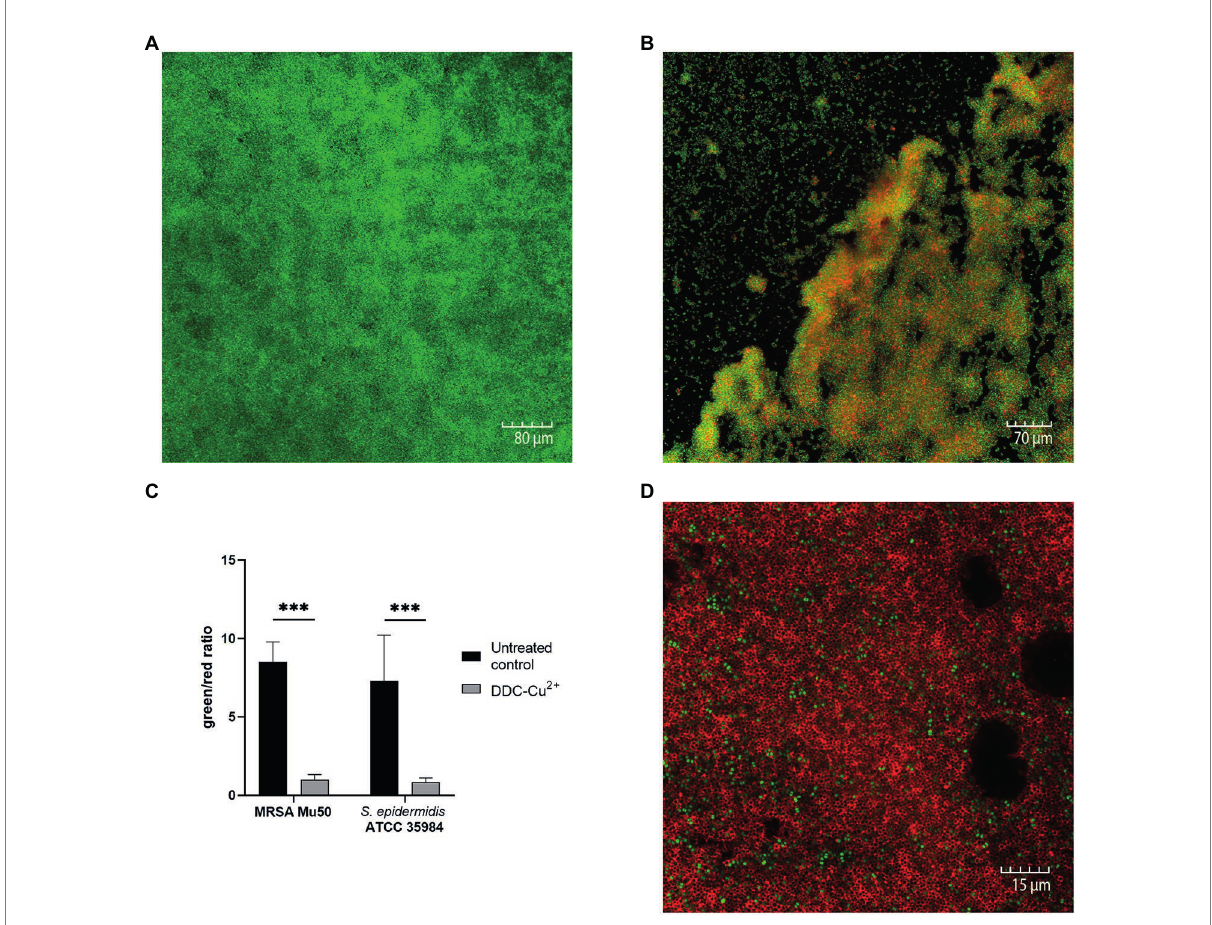
FIGURE 2 Comparison of stained MRSA Mu50 and S. epidermidis ATCC 35984 biofilms with LIVE/DEAD BacLight staining after treatment with 8 μ g/ml diethyldithiocarbamate and 32 μ g/ml Cu 2+ (DDC-Cu 2+ ). Confocal microscopy images results: green = viable bacteria; red = dead bacteria. (A) Untreated S. epidermidis ATCC 35984 biofilm at 20×. S. epidermidis ATCC 35984 biofilm after treatment with DDC-Cu 2+ at (B) 20× and (D) 100×. (C) Quantification of images as green/red ratio of untreated control (black) and treatment with DDC-Cu 2+ (grey) of MRSA and S. epidermidis ATCC 35984 biofilms ( n = 3–8; *** p <